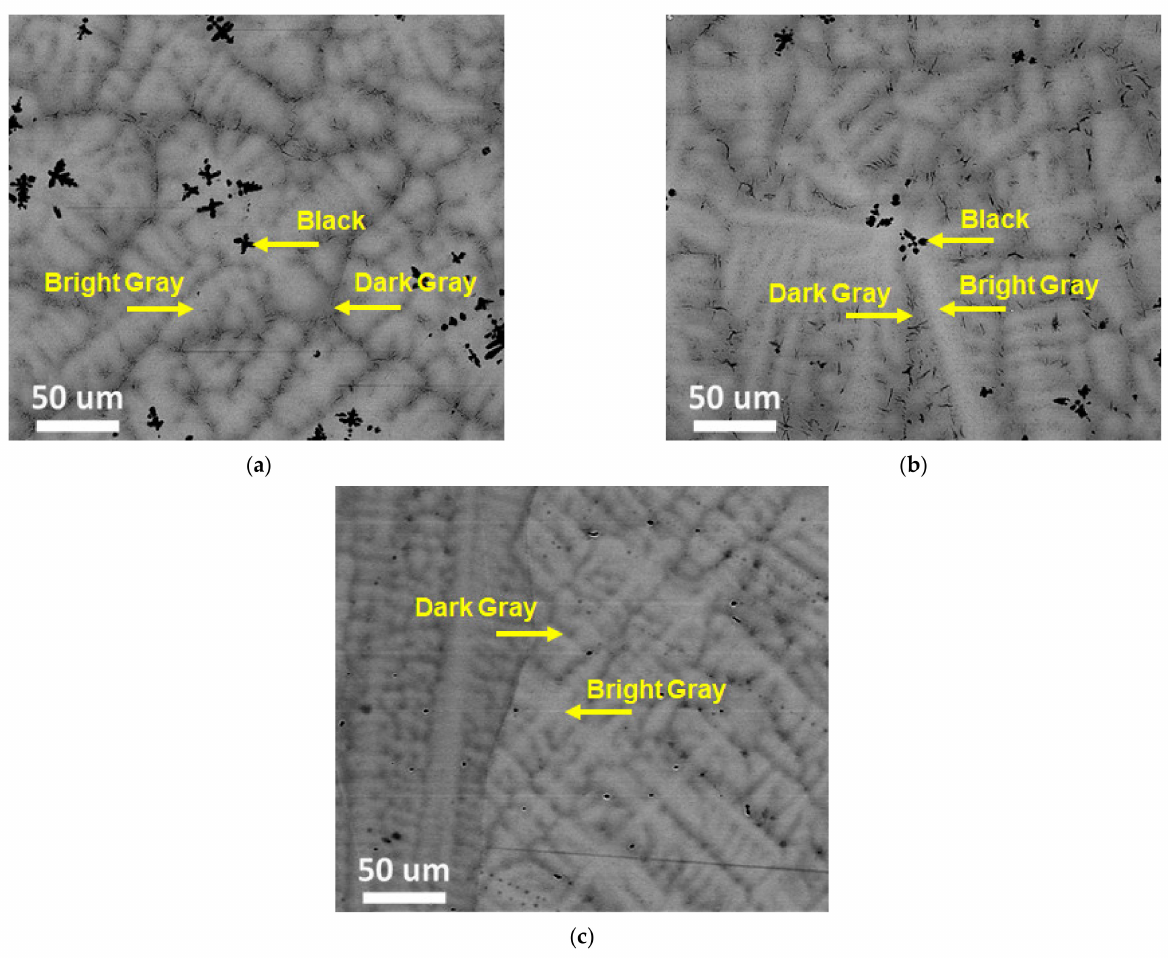
Figure 3. Backscattered electron micrograph of as-cast alloys: (TiVNb) 85 Cr 15 ( a ), (TiVNb) 75 Cr 25 ( b ) and (TiVNb) 65 Cr 35 ( c ).